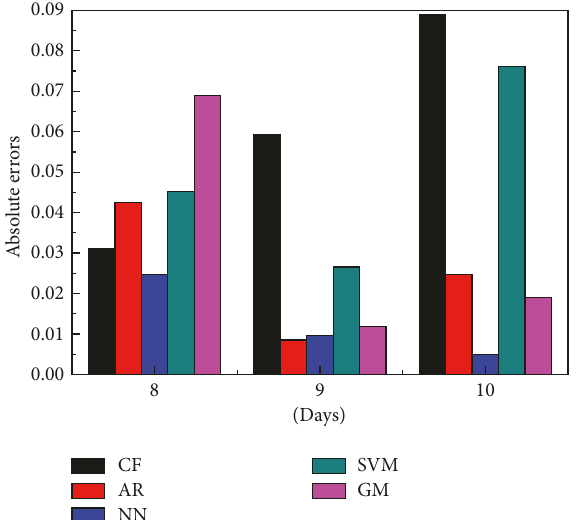
Figure6:Theabsoluteerrorbetweentheactualandpredictedvalues for the third